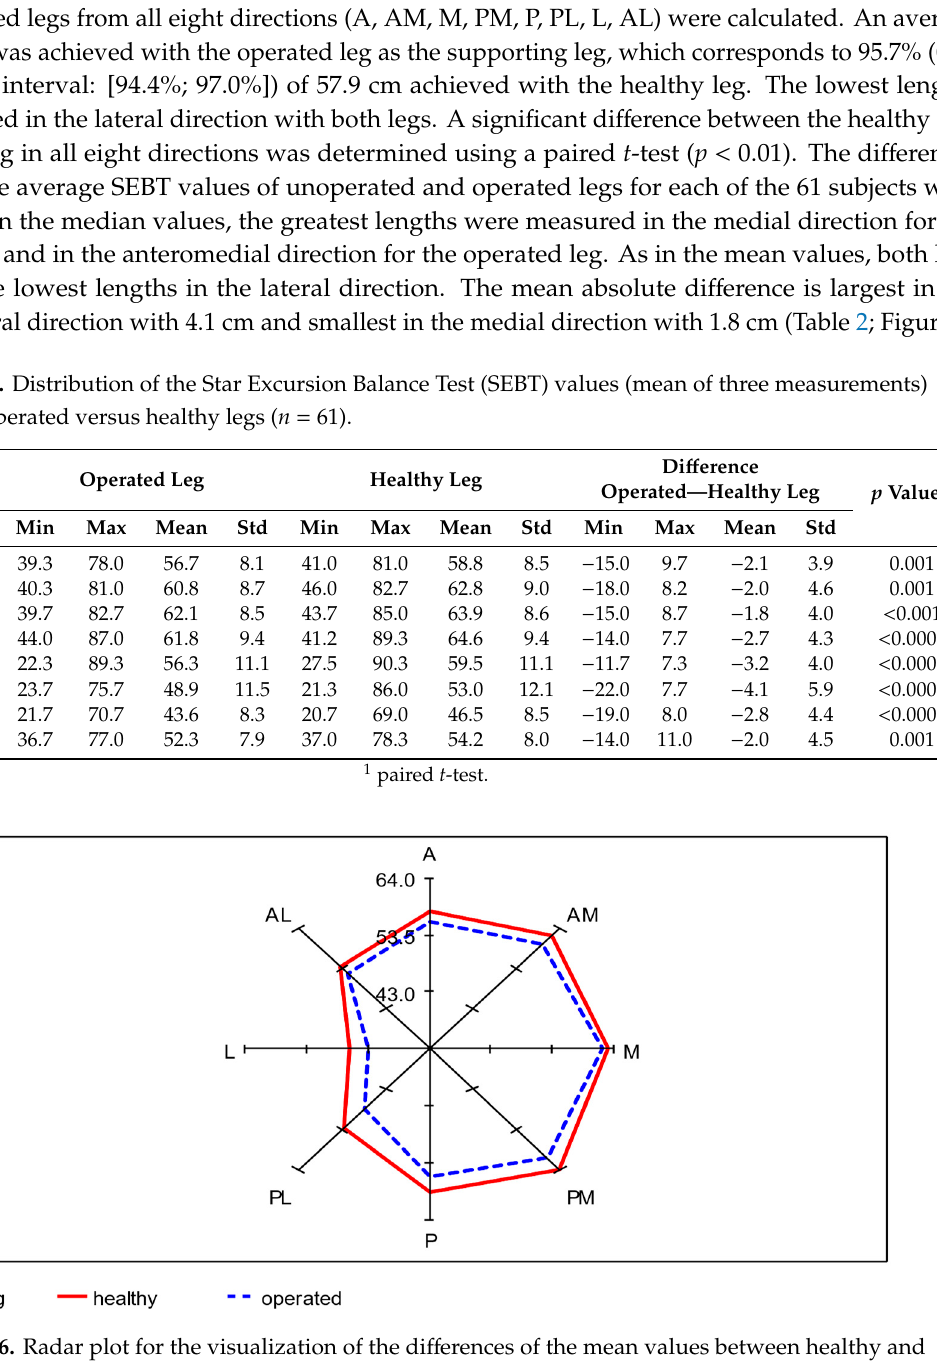
Figure 6. Radar plot for the visualization of the differences of the mean values between healthy and operated leg in each of the eight directions; n =